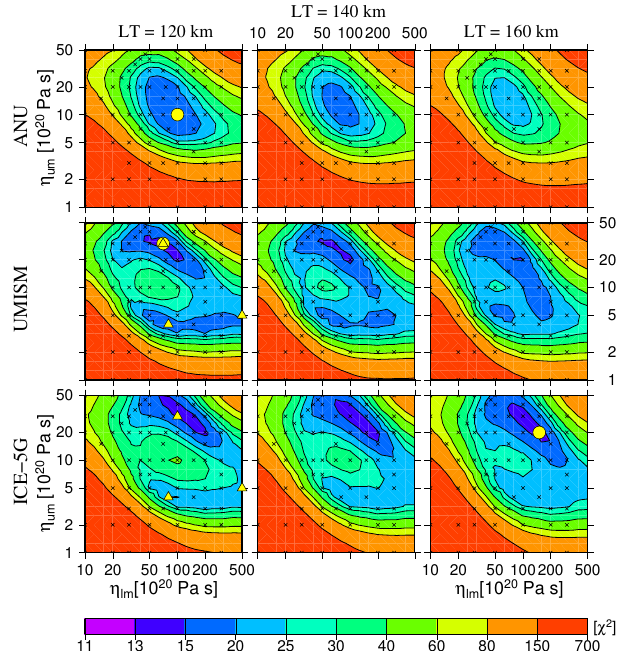
Figure 7. χ 2 v fit to the vertical displacement rates of the Bifrost data for GIA models using the ANU (upper row), ICE-5G (middle row) or UMISM (lower row) ice sheet reconstructions, as a func- tion of upper-mantle and lower-mantle viscosities ( η um and η lm ) and thickness of the lithosphere of 120km (left column), 140km (middle column) and 160km (right column). Tiny “x”s mark the lo- cations of tested parameter combinations, yellow circles mark the locations of best-fit models and yellow triangles mark the location of the UMISM and ICE-5G models compared in Fig.